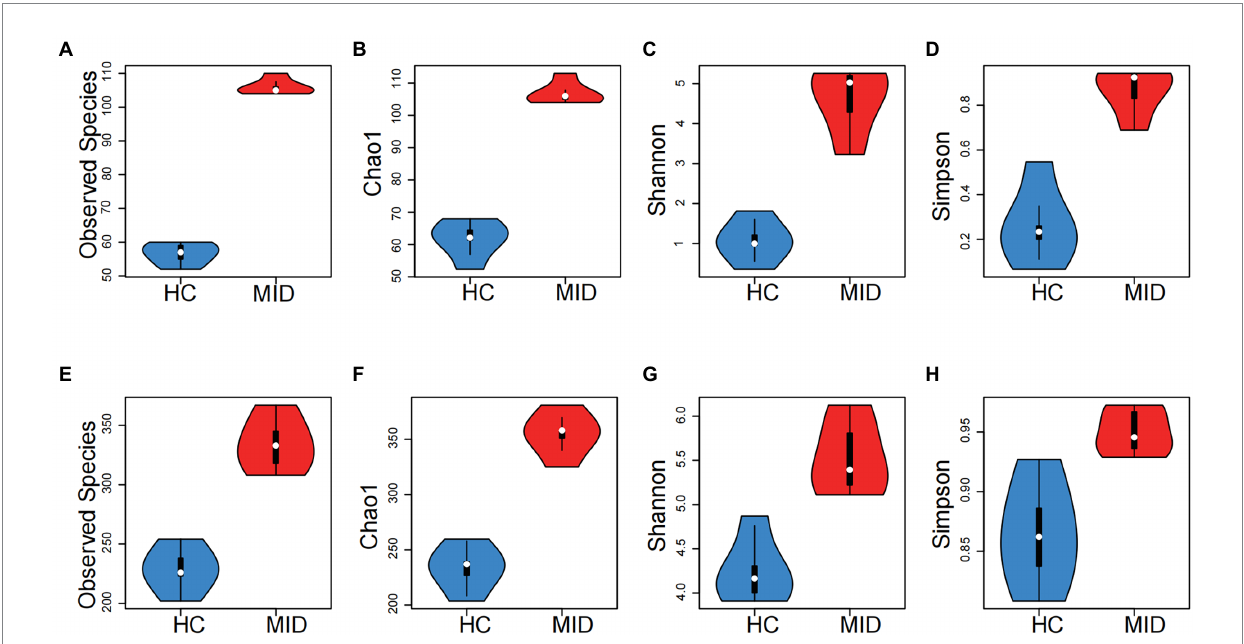
FIGURE 3 Group differences between oral (A–D) and intestinal (E–H) samples, MID group had significant higher diversity in both oral and intestinal microbiota than that of HC group ( p < 0.05 for all tests, t -test). The horizontal axis is the grouping, and the vertical axis is the alpha indexes (Observed specifications, Chao1, Shannon and Simpson). The white point represents the mean value, the outer contour represents the sample distribution, the upper side of the black box in the middle represents the upper 1/4, and the lower side represents the lower